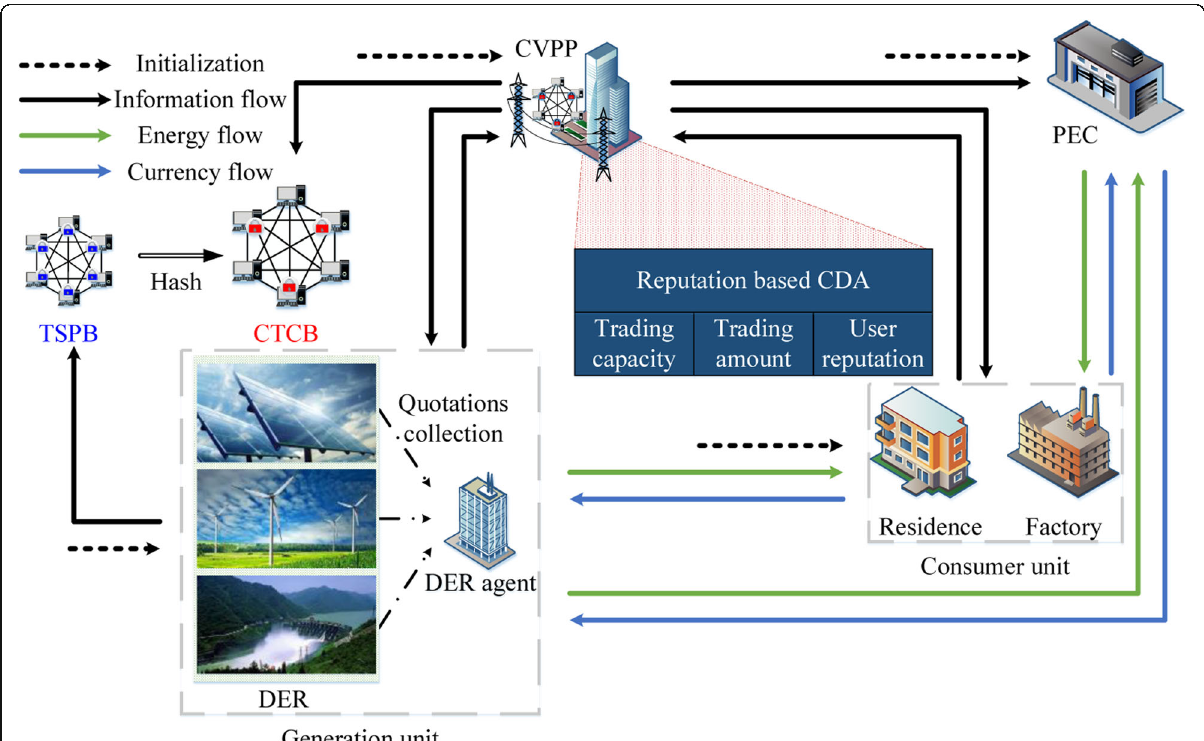
Fig. 6 VPP market trading model based on dual blockchains and